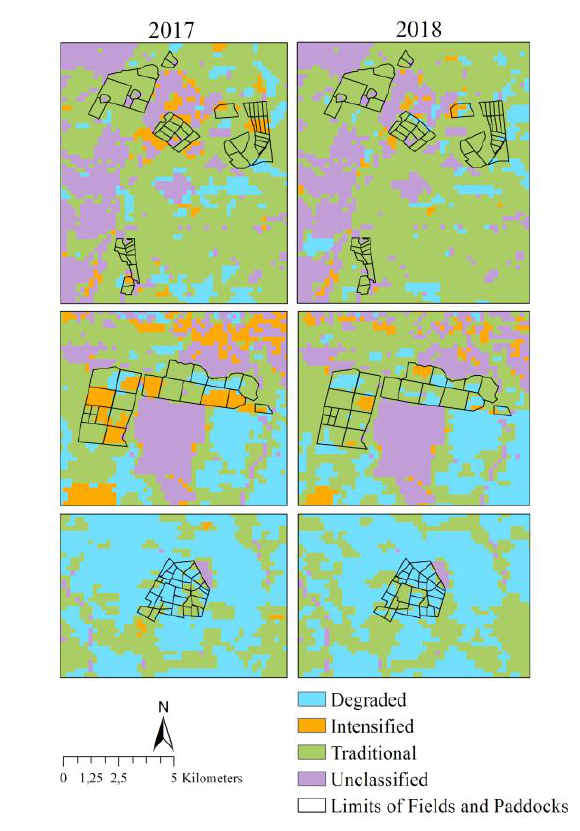
Figure 5. Land cover maps generated using the TWDTW classification method for the period of year 2017 (left) and 2018 (right) over the region of the four farms visited - upper: Farms 1 and 2; middle: Farm 4; and bottom: Farm 3. Unclassified regions represent the areas outside pasture and annual crops mask from the MapBiomas mapping Project for year 2017